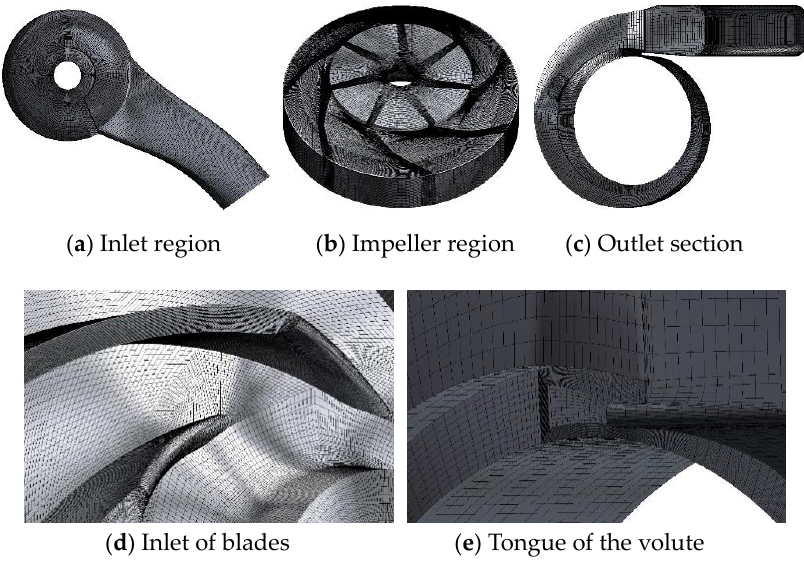
Figure 2. Mesh of computing domains.